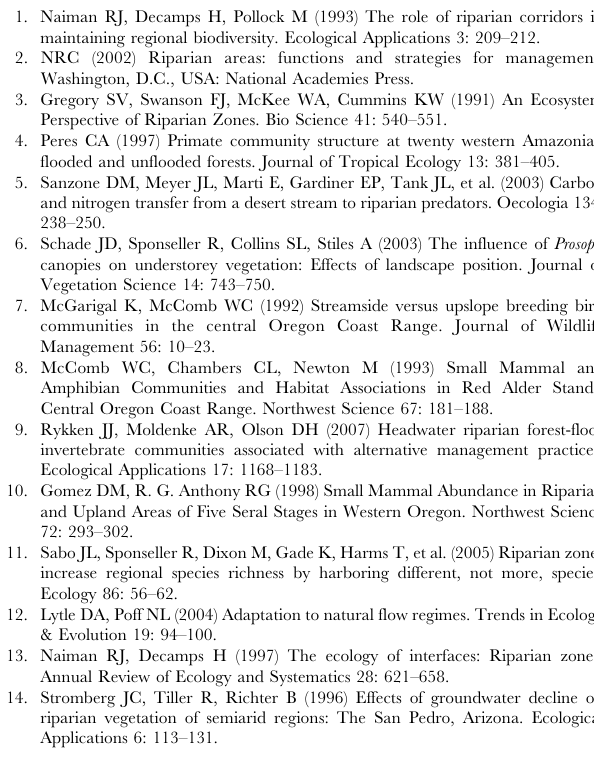
parisons. FP= river floodplain habitat type; RT = river terrace habitat type. Each point represents the unweighted effect size for a single taxonomic group belonging to one of the groupings. None of the trophic level comparisons were statistically significant at an alpha level of 0.05. Figure S2 Body size-based groupings for the riparian– upland and floodplain–river terrace (FP-RT) compari- sons. FP=river floodplain habitat type; RT=river terrace habitat type. Small , 0.1–10 grams; Medium , 10–1000 g; Large , 1– 100 kg. Each point represents the unweighted effect size for a single taxonomic group belonging to one of the groupings. None of the body size comparisons were statistically significant at an alpha level of 0.05. Figure S3 Lifespan-based groupings for the riparian– upland and floodplain–river terrace (FP-RT) compari- sons. FP= river floodplain habitat type; RT = river terrace habitat type. , 1 yr = less than one year; , 1 yr =approximately one year; . 1 yr = greater than one year. Each point represents the unweighted effect size for a single taxonomic group belonging to one of the groupings. There was a statistically significant difference in abundance between river floodplain and river terrace habitat types for lifespan-based groups (at an alpha level of 0.05). Figure S4 Thermoregulatory mechanism-based group- ings for the riparian–upland and floodplain–river ter- race (FP-RT) comparisons. FP =river floodplain habitat type; RT = river terrace habitat type. Each point represents the unweighted effect size for a single taxonomic group belonging to one of the groupings. None of the thermoregulatory mechanism comparisons were statistically significant at an alpha level of 0.05.